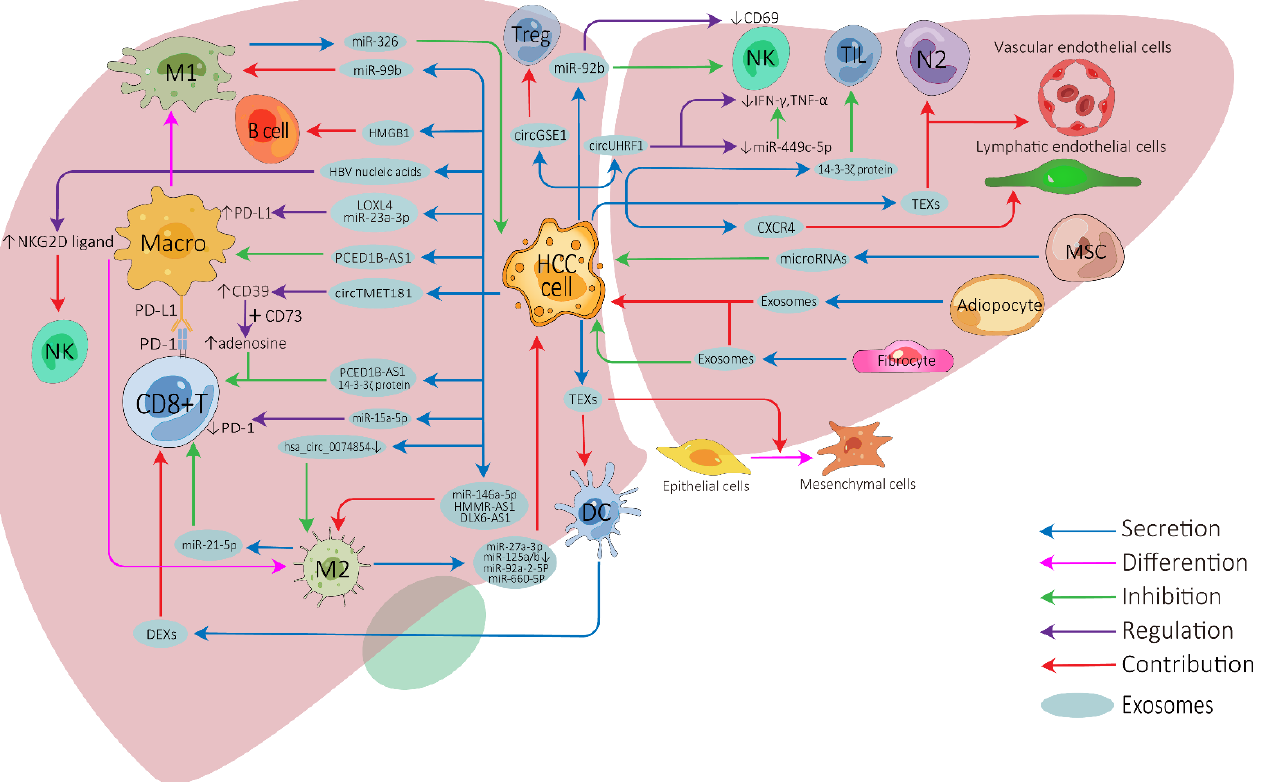
Figure 1. Exosome-mediated cell-to-cell communications between different cells in the HCC tumor microenvironment. HCC, hepatocellular carcinoma; Treg, regulatory T cell; NK, natural killer cell; Macro, macrophage; M1, M1-polarized macrophage; M2, M2-polarized macrophage; DC, dendritic cell; MSC, mesenchymal stem cell; N2, N2-neutrophil; TIL, tumor-infiltrating lymphocyte; TEXs, tumor-cell-derived exosomes; DEXs, DC-derived exosomes; PD-1, programmed cell death protein 1; PD-L1, programmed cell death ligand 1.